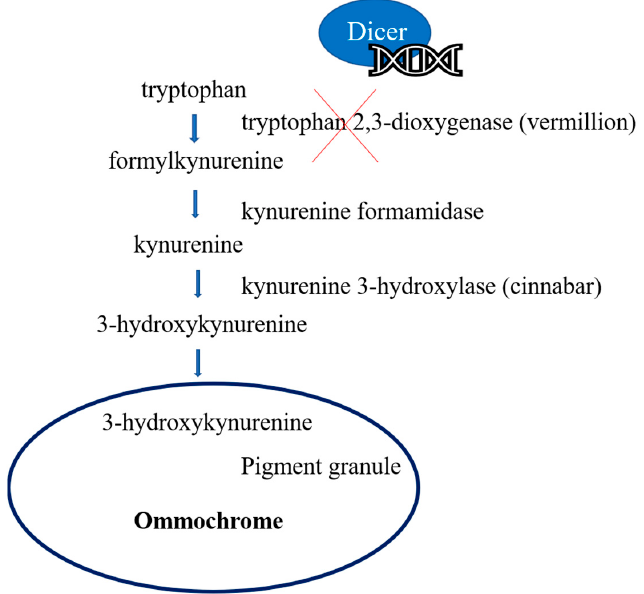
Figure 5. Model of the ommochrome biosynthesis pathway in beetle pigmentation.